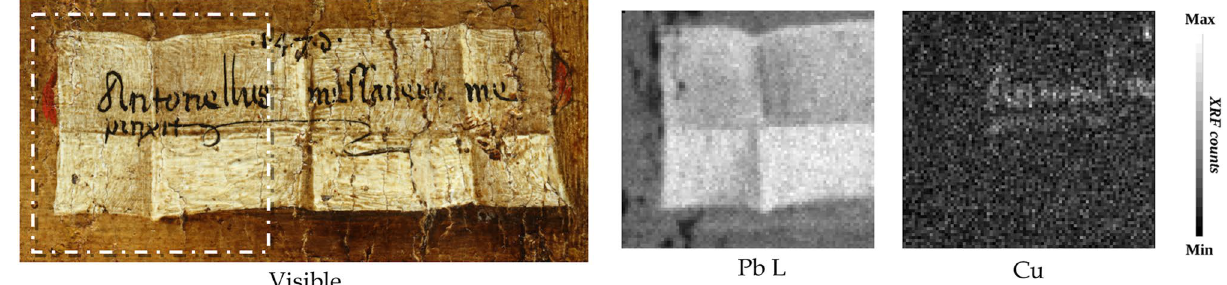
Figure 10. Analysis of the cartouche. Picture in visible light (photo by Carlo Pagani) of the cartouche and the distribution of Pb L and Cu obtained by X-ray fluorescence (MA-XRF) mapping analyses, related to the sub-area highlighted with dots (2.5 × 2.1 cm).